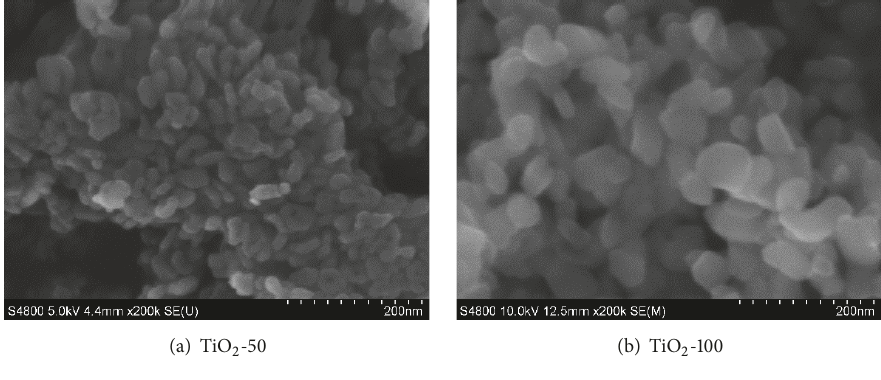
Figure 1: Electron microscope scanning images.